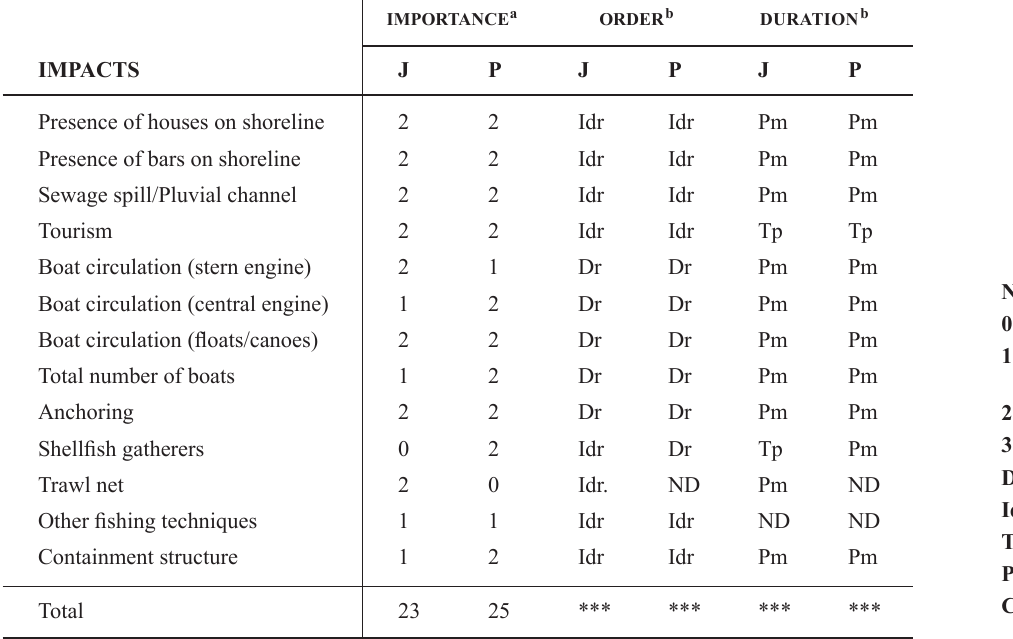
Font: a Modified from Singer (1985); b Adapted from Feuerschutte